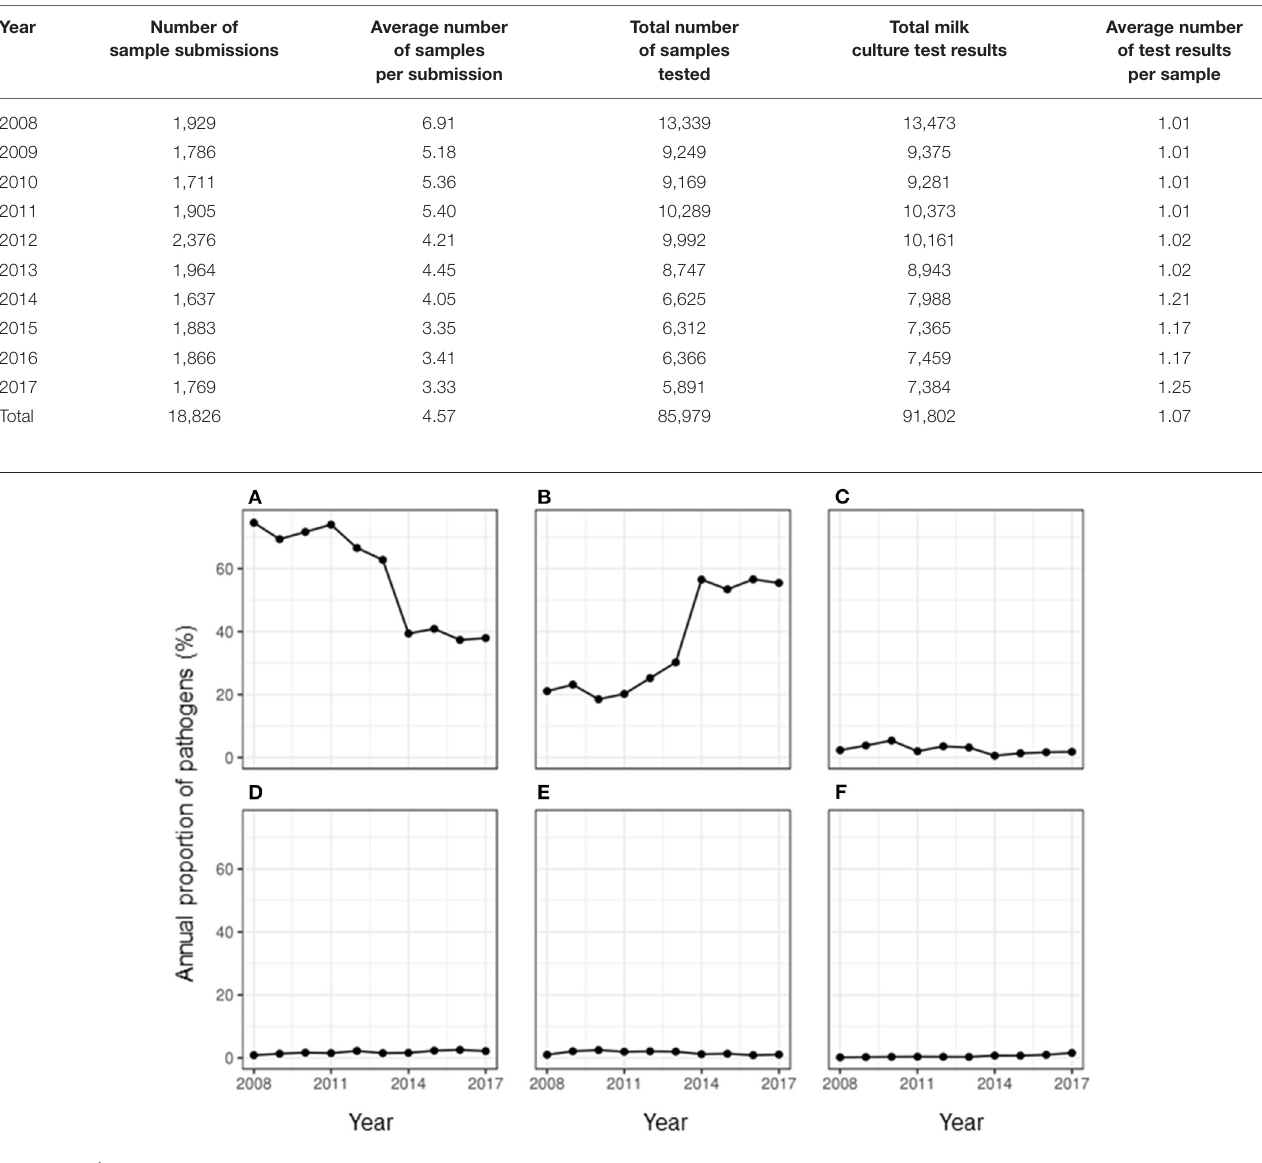
(69.02%), S. simulans (14.45%), S. epidermidis (12.99%), and S. hyicus